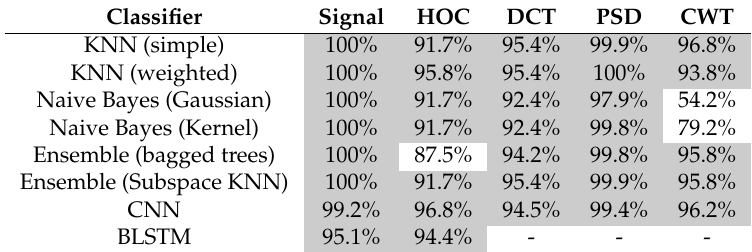
Table 2. Classification accuracy for healthy versus damaged sample (diameter 500 µ m). Accuracy of better than 90% is shown in grey background. (CNN = convolutional neural network; BLSTM = bidirectional long short term memory; CWT = continuous wavelet